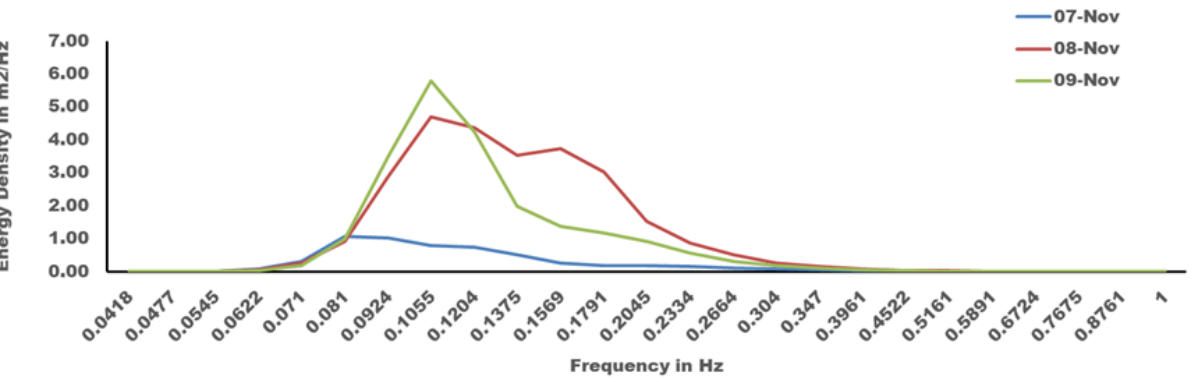
Figure 17. Computed daily wave spectra (m 2 /Hz) for BULBUL cyclone at 88° E and 21° N using SCATSAT − 1 daily 25 km wind data.